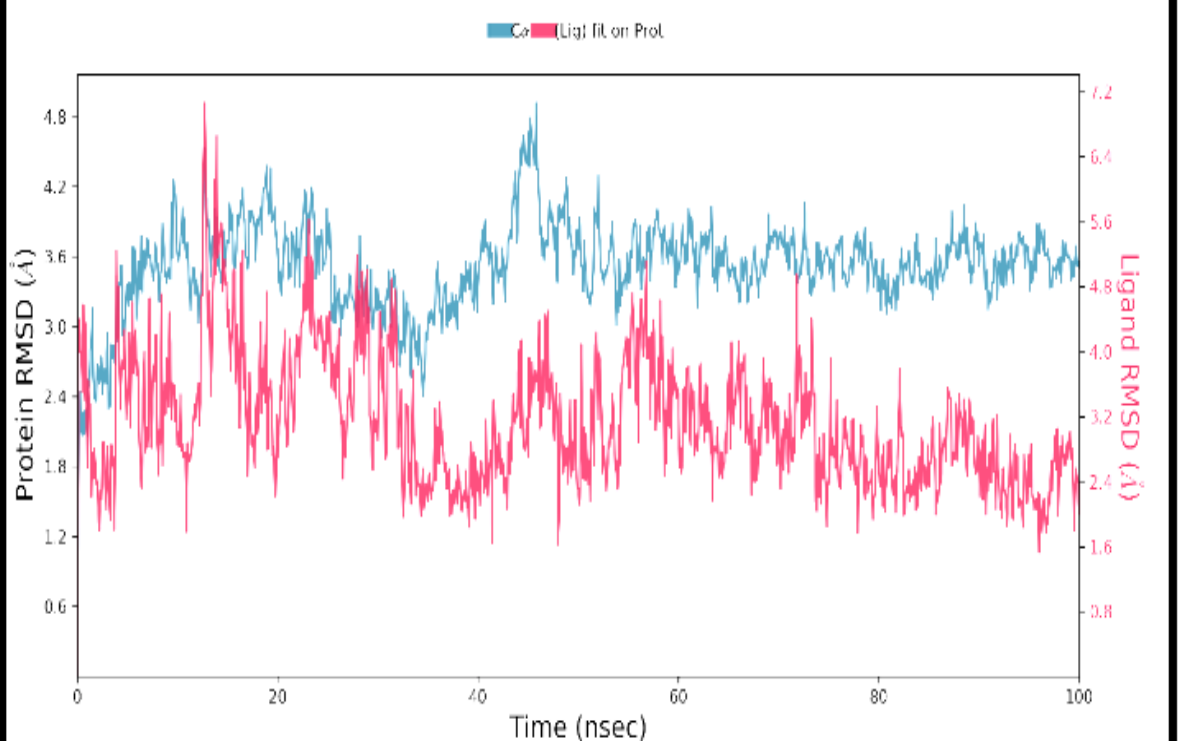
Figure 3. Root mean square deviation (RMSD) of the protein–ligand complex.